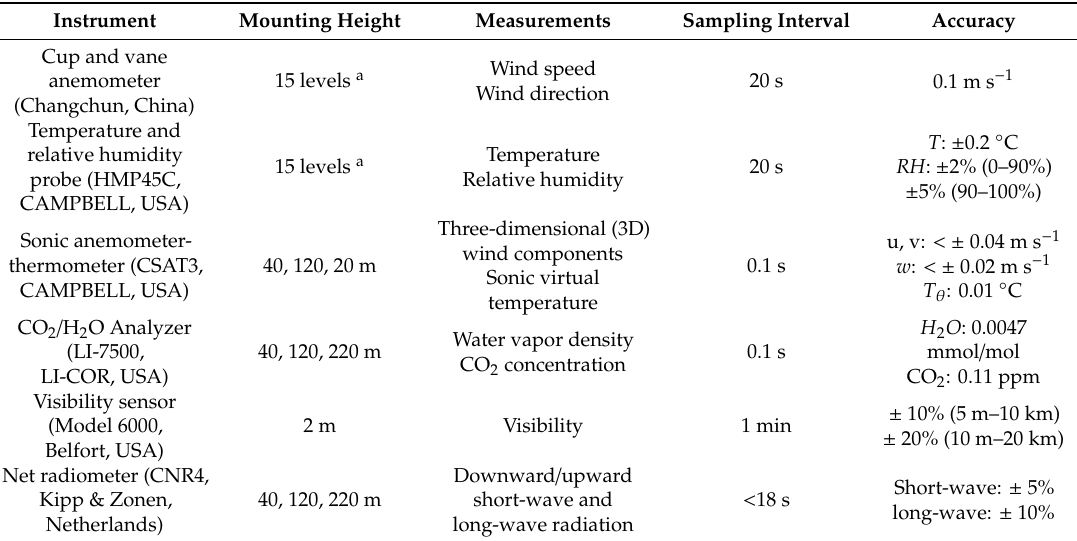
Table 1. List of instruments used in this